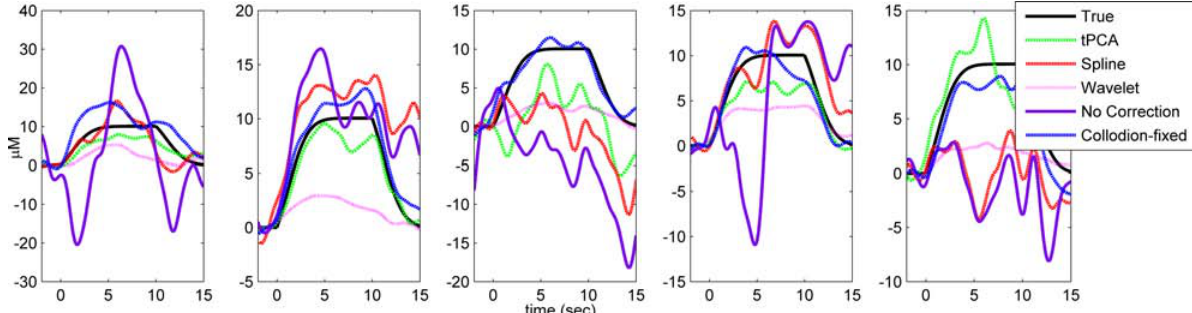
Fig. 3. The HRFs (in micromolars) for one run from each subject obtained by block averaging the uncorrected data (velcro probe: purple line; collodion-¯xed probe: blue-dashed line), tPCA corrected (green), spline interpolation corrected (red) and wavelet-based ¯lter corrected data (pink). The true HRF is shown in black.